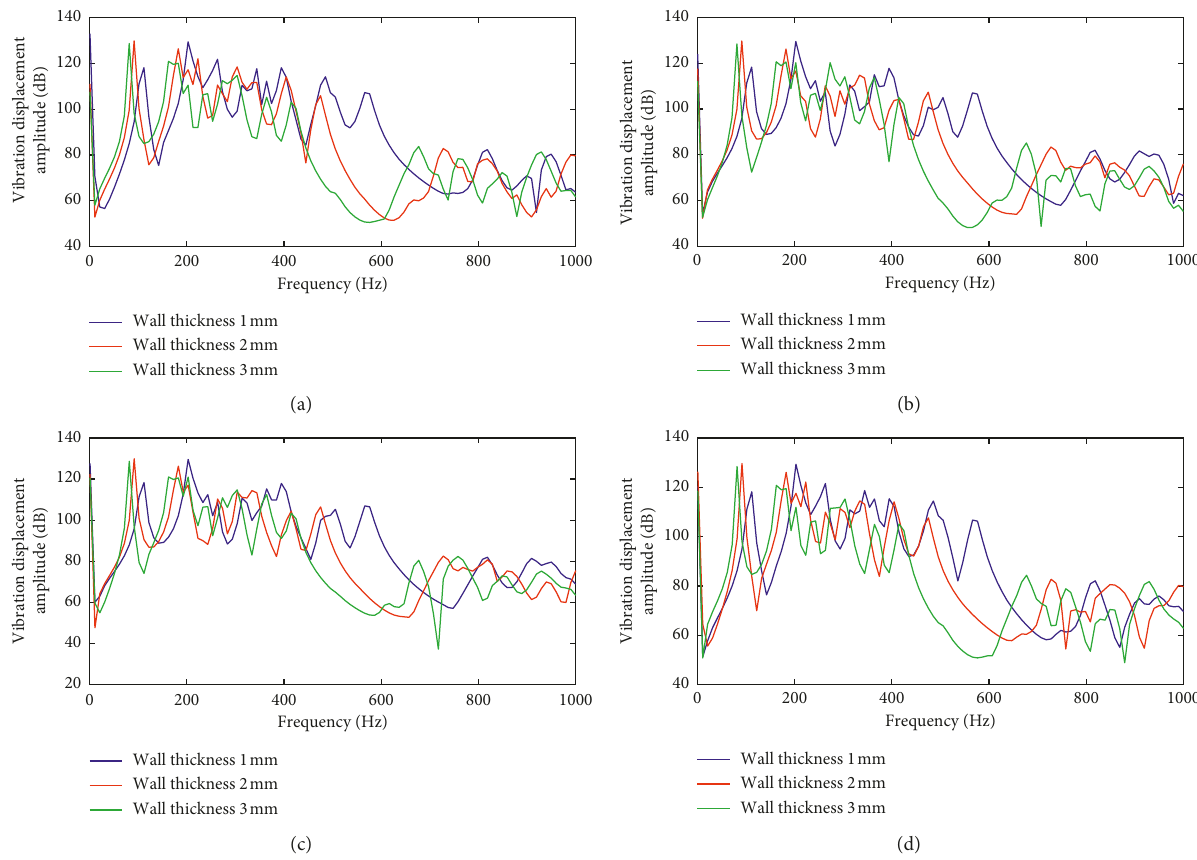
Figure 5: Harmonic response curves at different joint wall thickness at measuring points (a) 1, (b) 2, (c) 3, and (d) 4.